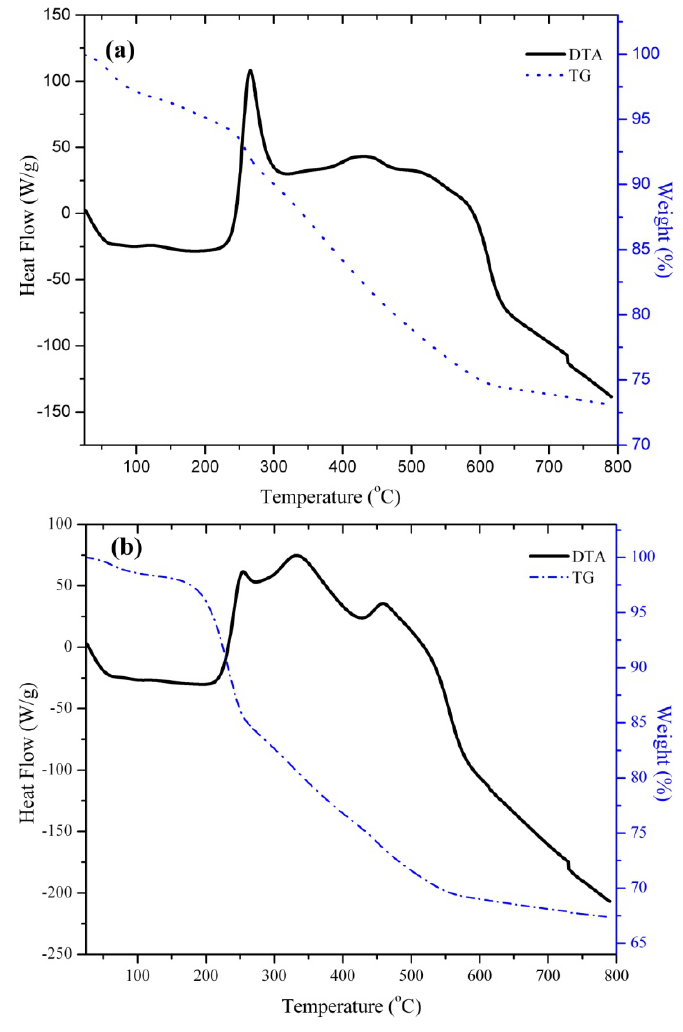
catalyst and ( b ) SG-MNP-NMe 2